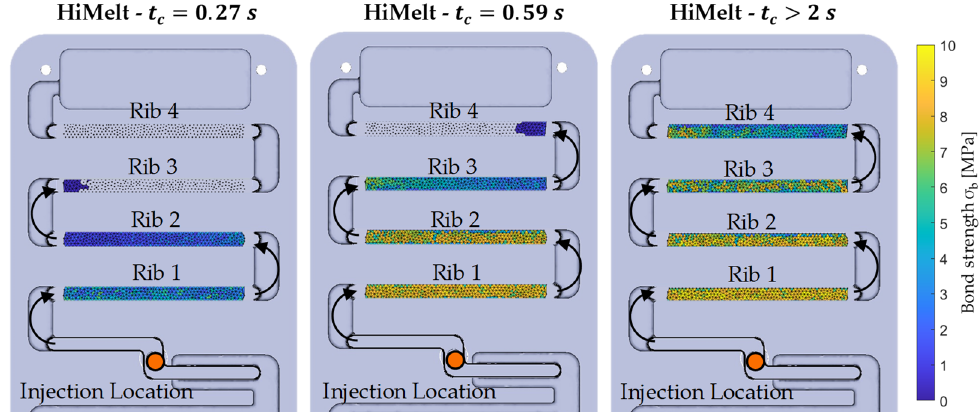
Figure 15. Demonstration of the developing bond strength during specific contact times shown as an example for a high melt temperature “HiMelt” (cf. Table 1).